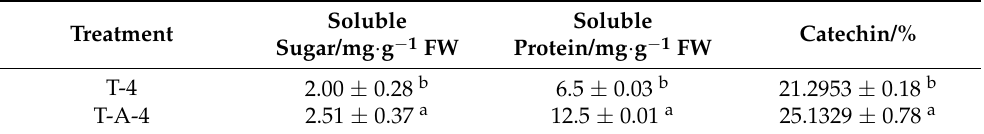
Table 1. Effect of exogenous ALA on the soluble sugar, soluble protein and catechin of tea leaves under cold stress.